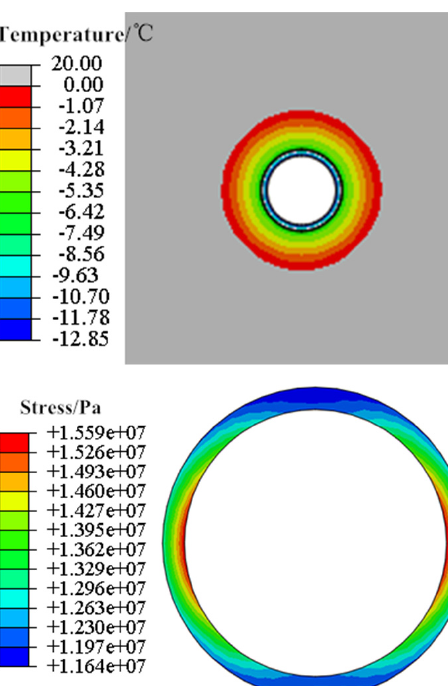
Figure 5. Annular distribution of frost heave force of rock mass with different thermal expansion coefficients (unit: MPa).